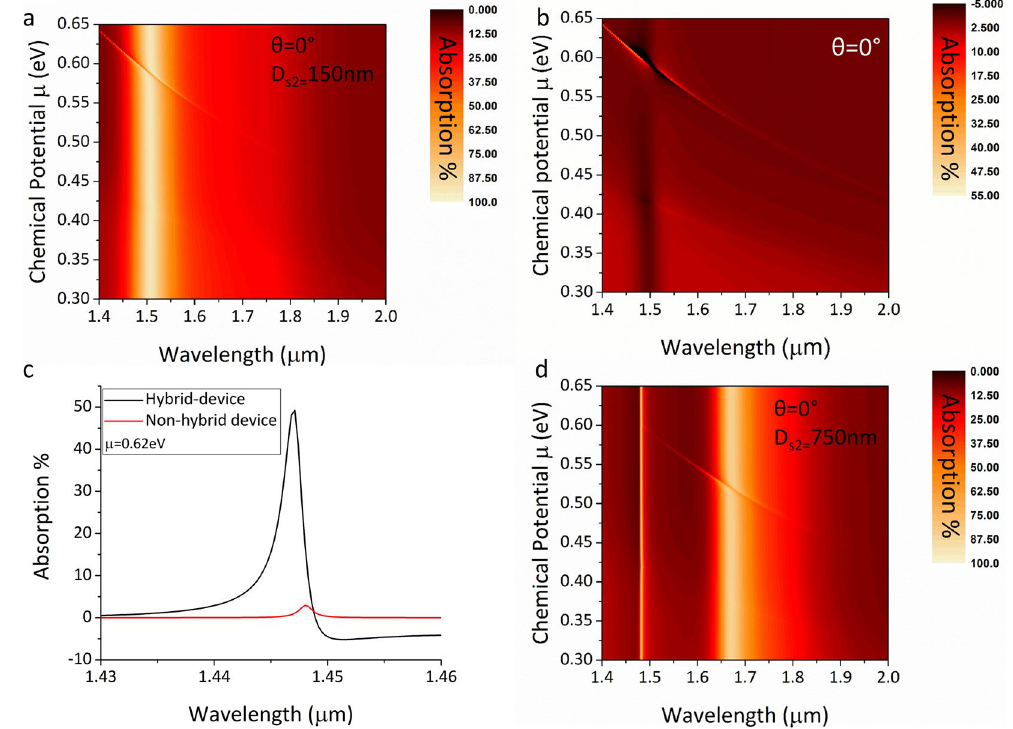
Figure 4. RCWA simulation spectra for the hybrid device setup where large tuneable optical absorption approaching 100% can be observed. ( a ) Resulting spectra for a device with 150 nm ionic gel thickness. ( b ) Absorption attributed only to the graphene layer for the same setup by subtracting absorption due to the grating structure and other layers. ( c ) Comparison of absorption between non-hybrid and hybrid device. ( d ) Resulting spectra for a device with an ionic gel thickness of 750